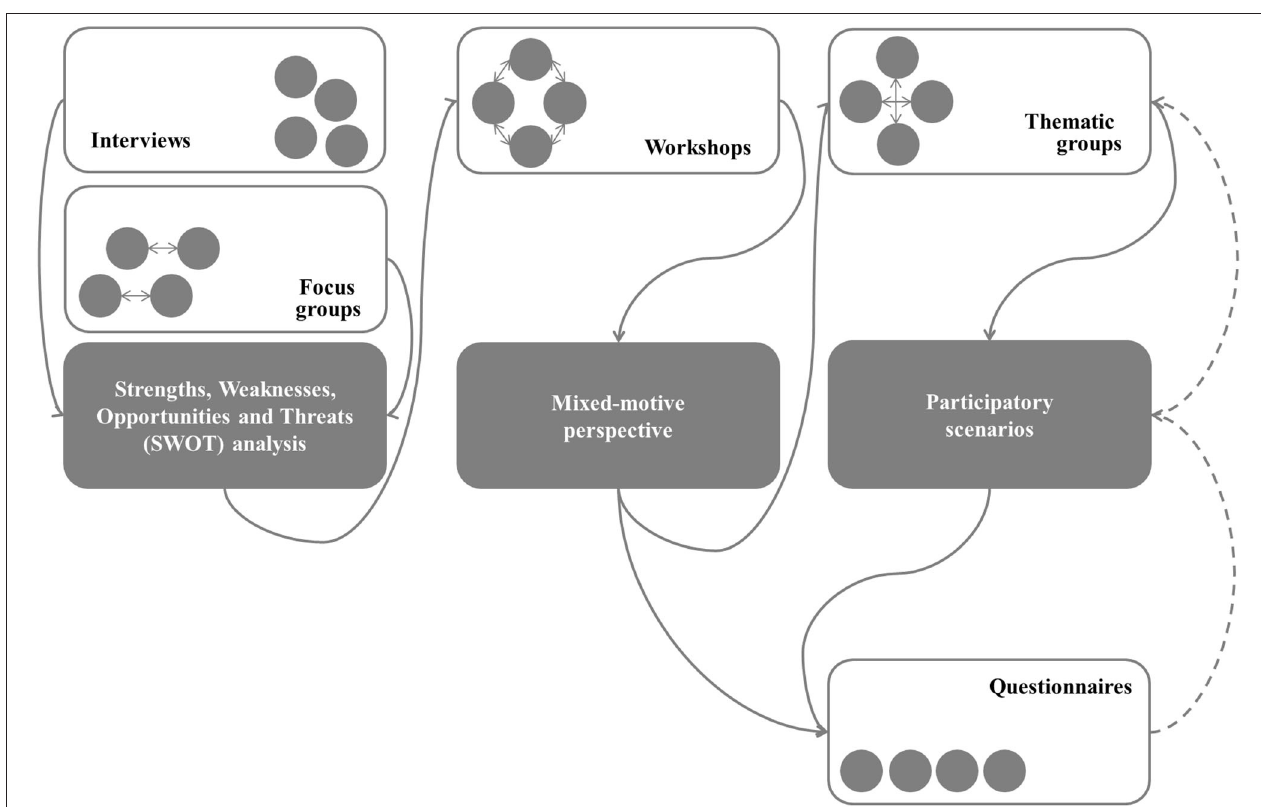
FIGURE 2 | The modular sequence of the social learning methodology, with procedures in white rectangles and deliverables in dark rectangles. A detailed explanation of procedures, which serve as input for data collection and analysis can be found in the Methods section, Data Sources and Data Analyses . Deliverables take the form of completed templates, which scaffold social learning [Strengths, Weaknesses, Opportunities, and Threats (SWOT) analysis template; mixed-motive template; template for participatory scenario development]. Cycles in rectangles represent participant interaction: no interaction in interviews and questionnaires, bilateral interaction between stakeholders in focus groups, plenary session in workshops, and multi-stakeholder interaction in thematic groups. Arrows depict the flow of information, knowledge, and experience